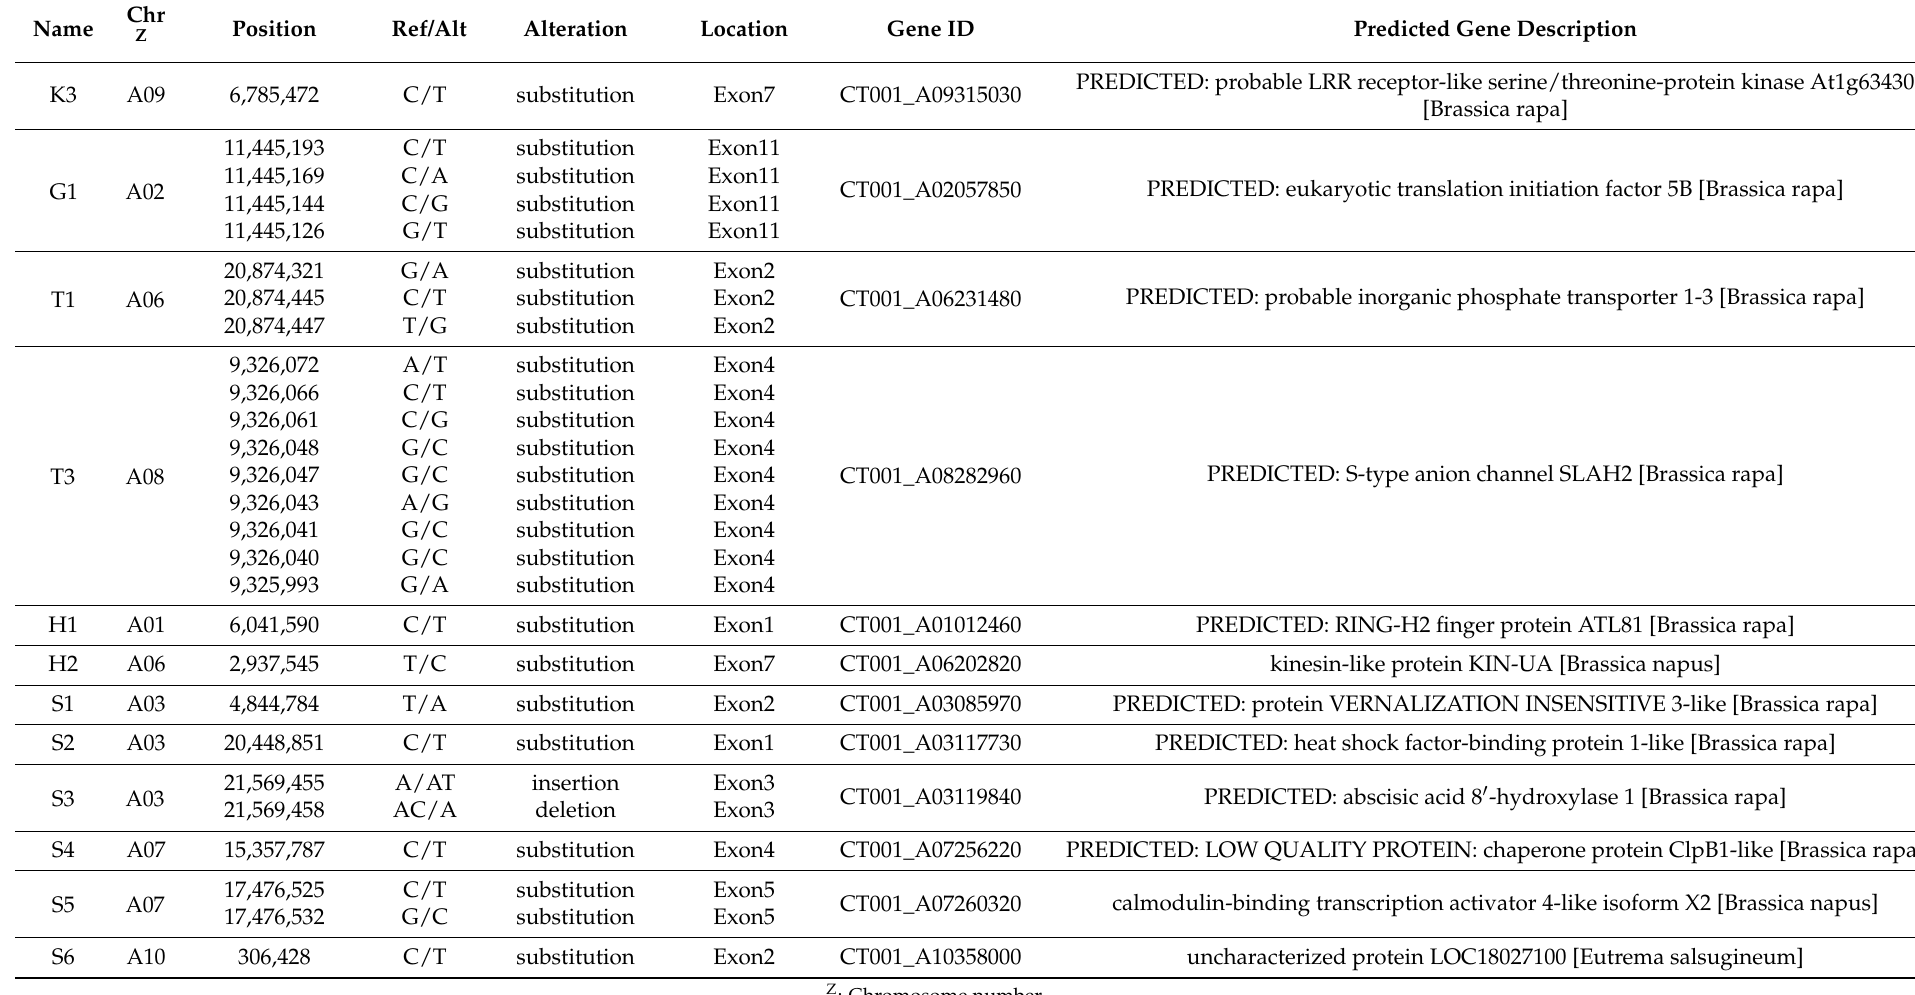
Table 4. Description of genes with the exonic SNP and InDel in the T 1 and T 3 transgenic Chinese cabbage